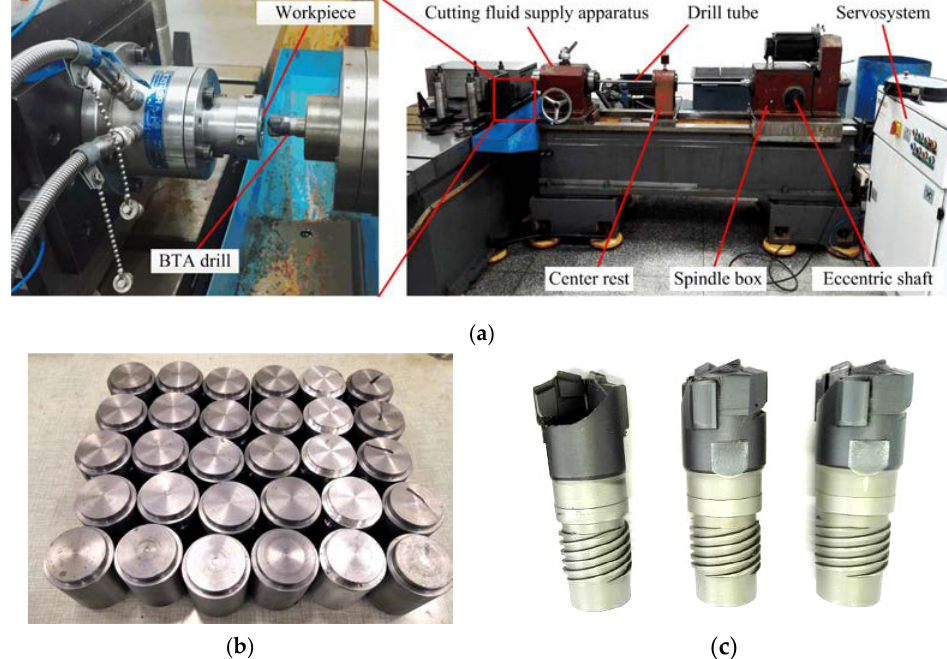
Figure 12. Equipment for deep hole machining tests: ( a ) deep hole machining machine; ( b ) workpiece; ( c ) 17.75 BTA drill.